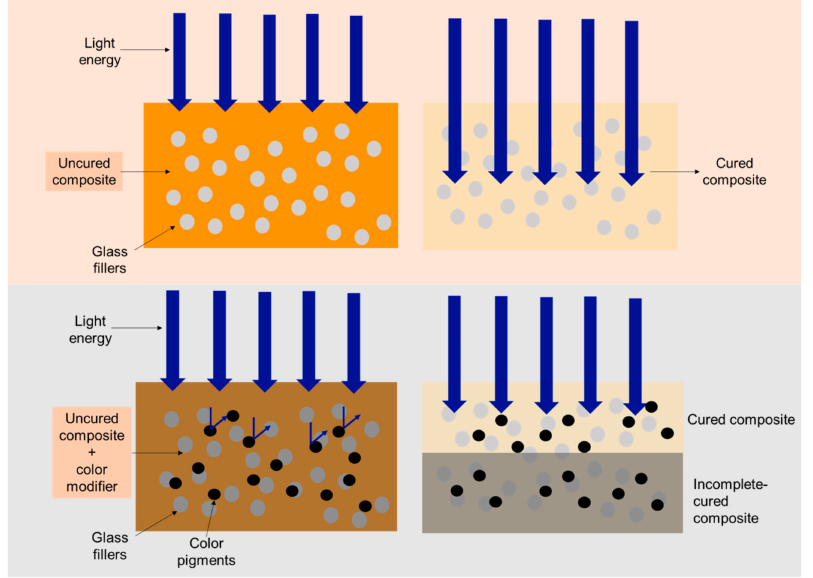
Figure 7. The addition of color modifiers reduced the degree of monomer conversion of resin